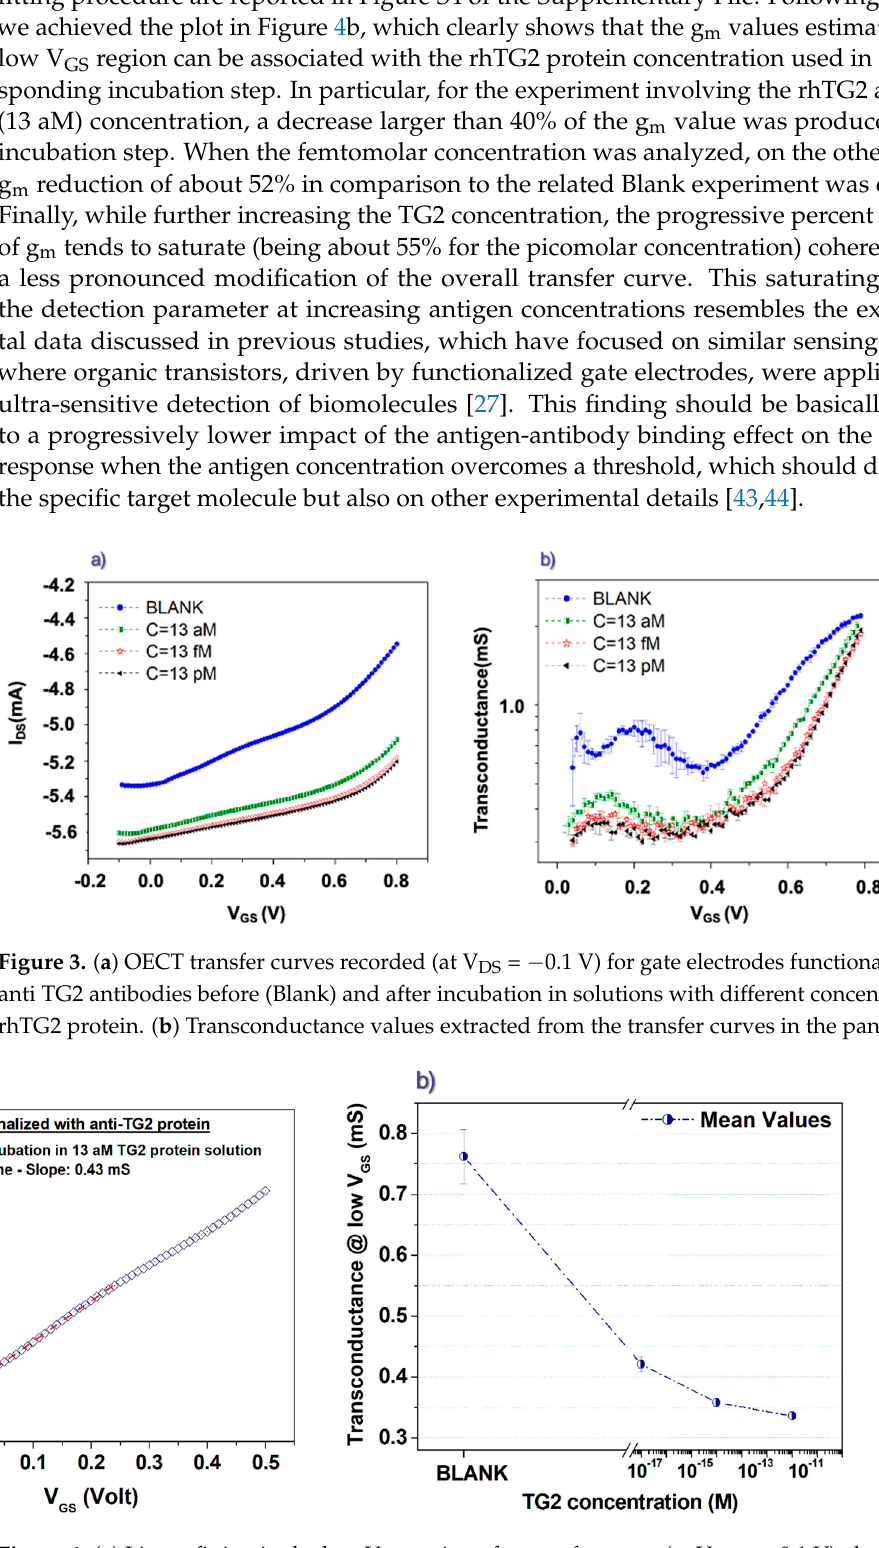
Figure 4. ( a ) Linear fitting in the low V GS region of a transfer curve (at V DS = − 0.1 V) obtained for a gate electrode functionalized with anti-TG2 antibodies after incubation in solution with attomolar concentration of rhTG2 protein. ( b ) Transconductance values extracted as a function of the rhTG2 protein concentration in the incubation solution.